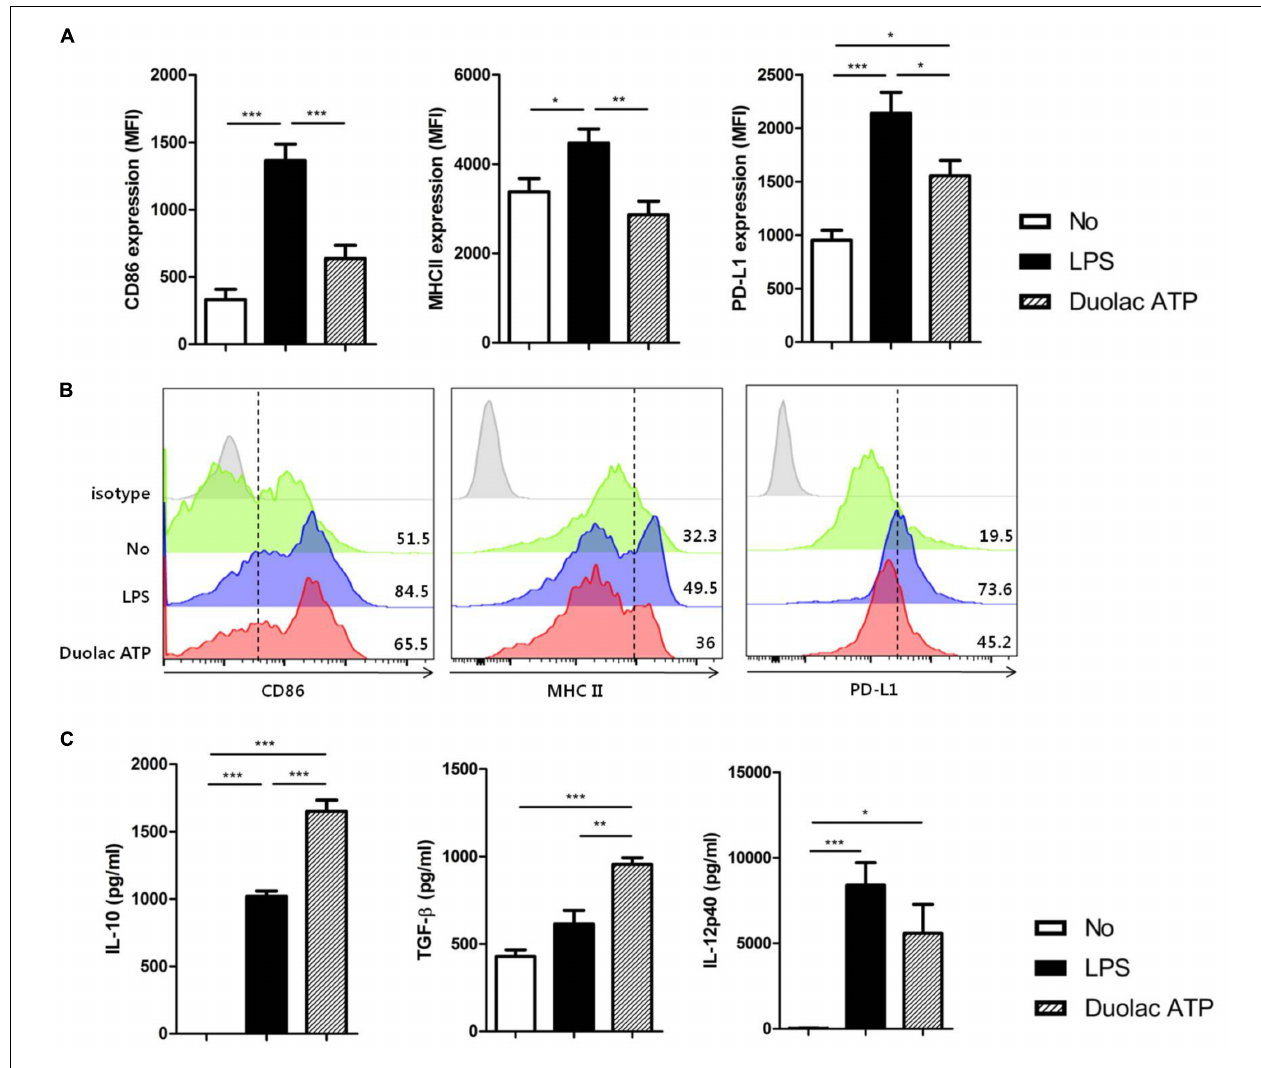
FIGURE 1 | Duolac ATP induced regulatory molecules in bone marrow-derived dendritic cells (BMDCs). BMDCs were treated with LPS and/or 2 × 10 6 CFU of Duolac ATP for 24 h. (A) The expression of surface markers and (B) a representative histogram of CD86, MHC II, and PD-L1 on BMDCs were measured by flow cytometry. (C) The expression of cytokines in the supernatants was measured by ELISA. Data are representative of at least three experiments. ∗ P < 0.05, ∗∗ P < 0.01, ∗∗∗ P < 0.001 using one-way ANOVA with Tukey’s multiple comparison test. Bars indicate mean ± SEM.